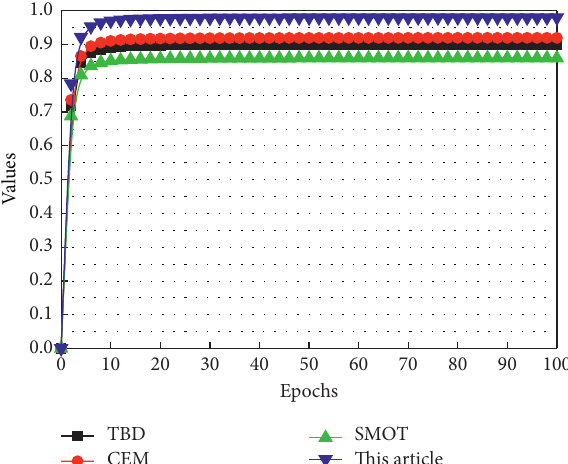
Figure 5: Comparison of the tracking results between this algorithm and other